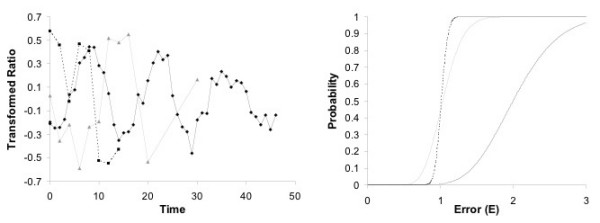
Time series data (left) and corresponding error distribution functions for specific genes: the solid line is data set TT3 for gene CCNB1 (a = 22.8, b = 0.0458, a/b = 498), the grey line is TT1 for CCNE1 (a = 9.3, b = 0.0120, a/b = 77), and the dashed line is Shake for CDKN3 (a = 197, b = 0.00517, a/b = 38 092).